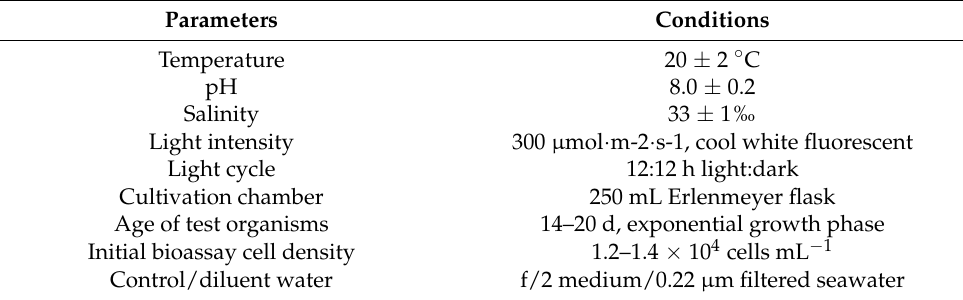
Table 5. Microalgae cultivation